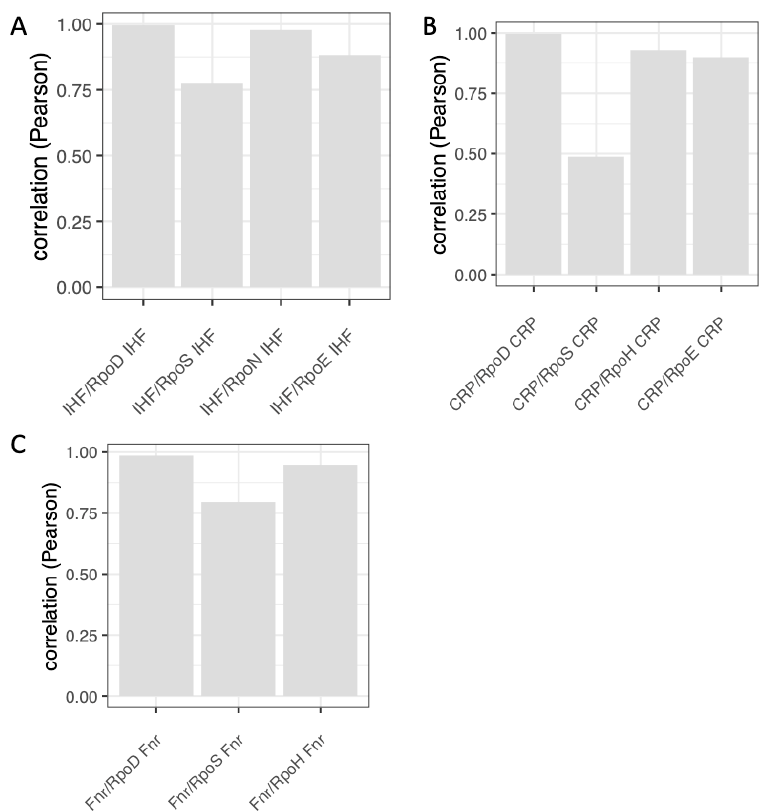
Figure 8. The temporal regulon/couplon correlation patterns for IHF and global TFs. ( A ). Pearson correlation between the expression of IHF regulon, IHF/RpoD and IHF/ASF couplons. ( B , C ), the same as in ( A ), but for CRP and Fnr, respectively Note that the couplon patterns show positive correlation with those of IHF and global TFs irrespective of the involved sigma factor (data from [29]). BA